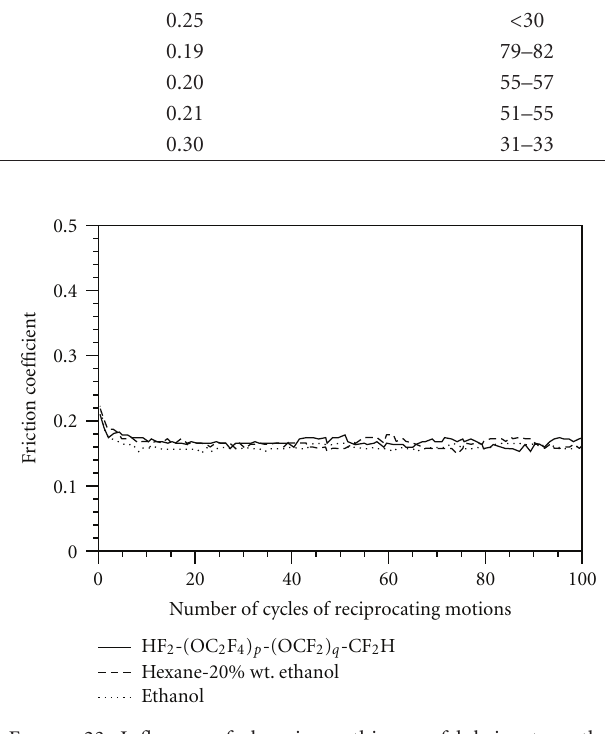
Figure 23: Influence of changing a thinner of lubricant on the friction coe ffi